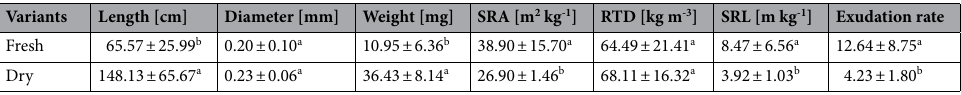
Table 2. Mean morphological characteristics of roots and exudation rate (mg C g -1 day -1 ) in different moisture variant. Mean ± standard deviation; root tissue density (RTD), specific root area (SRA) and specific root length (SRL); a, b—statistically significant parameters; p < 0.05 ).